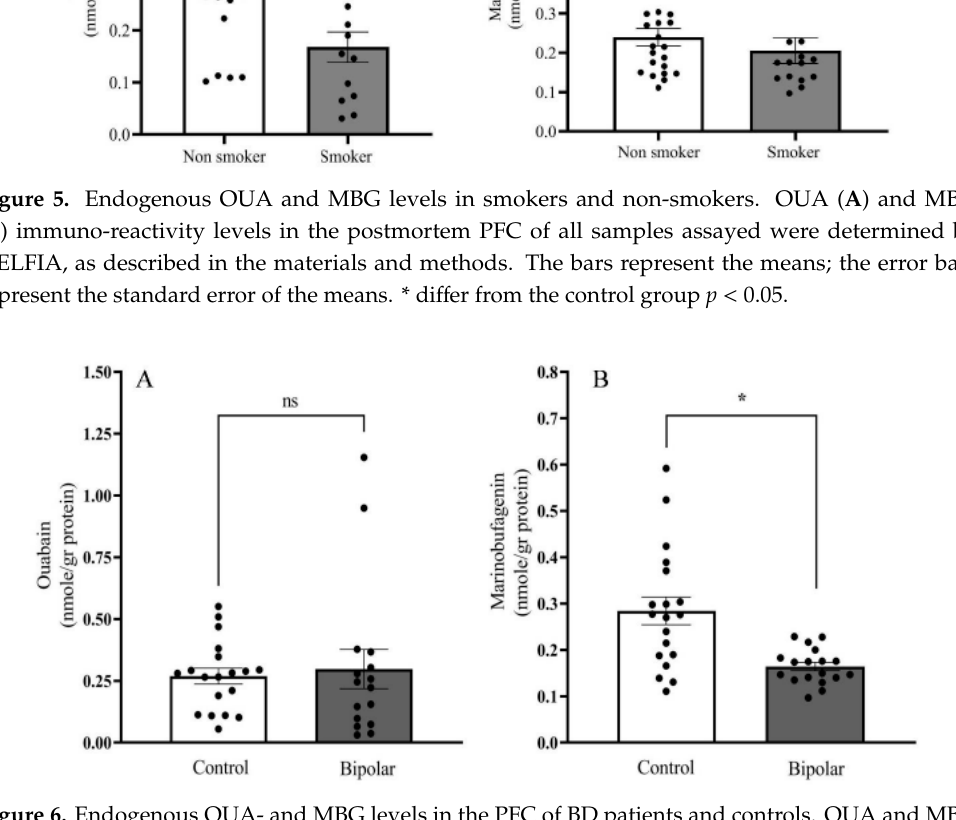
Figure 6. Endogenous OUA- and MBG levels in the PFC of BD patients and controls. OUA and MBG immuno-reactivity levels in postmortem PFC samples of controls ( A ) and BD ( B ) patients ( n = 16–19) were determined with DELFIA, as described in the materials and methods. The bars represent the means; the error bars represent the standard error of the means; * differ from the control group p < 0.05; ns: non-significant.